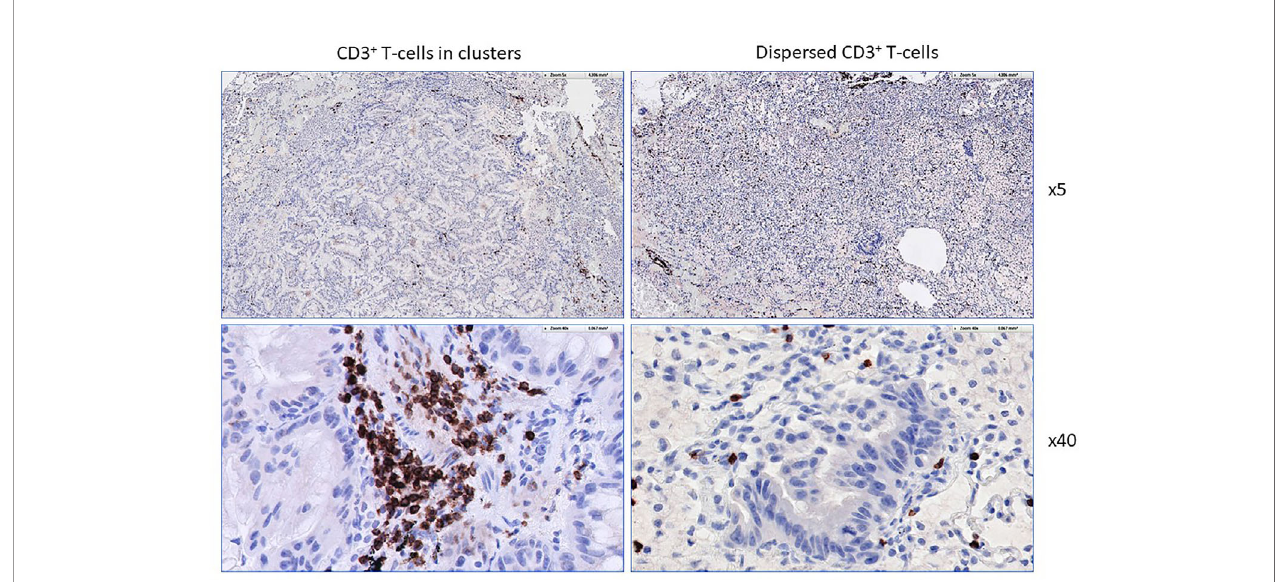
FIGURE 7 | Different immune-textures in cancer lesions. Starting point for WES and RNA-Seq. De fi nition and documentation of the immune cell in fi ltrate. Parallel slices of the paraf fi n-embedded tissues are procured and subjected to DNA and RNA analysis. Note the different patterns of CD3 + T-cell clusters (left) versus individual CD3 + T-cells in close proximity to tumor cells. RNA isolated from this tumor section would also allow for deep TCR-sequencing and allow to trace back individual TCR CDR3 motifs in case if neoepitope speci fi c TCRs are identi fi ed.